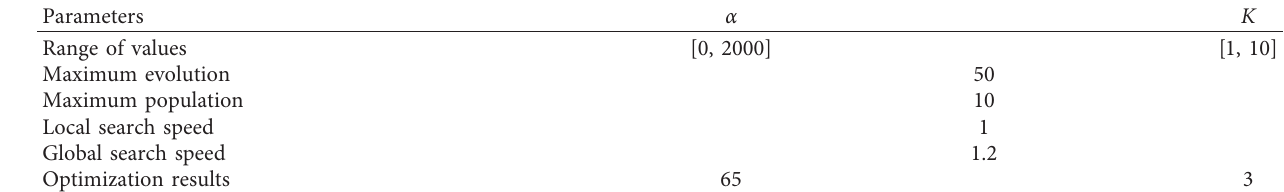
Table 5: Parameters setting and optimization results of PSO.